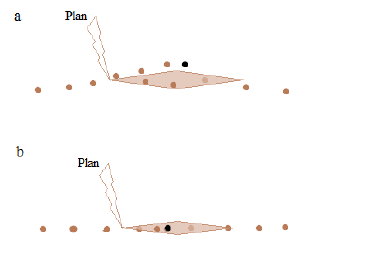
Figure 2: The black dots represent the uniform surfaces, while the whites represent the non-uniform surfaces, for example, trees.